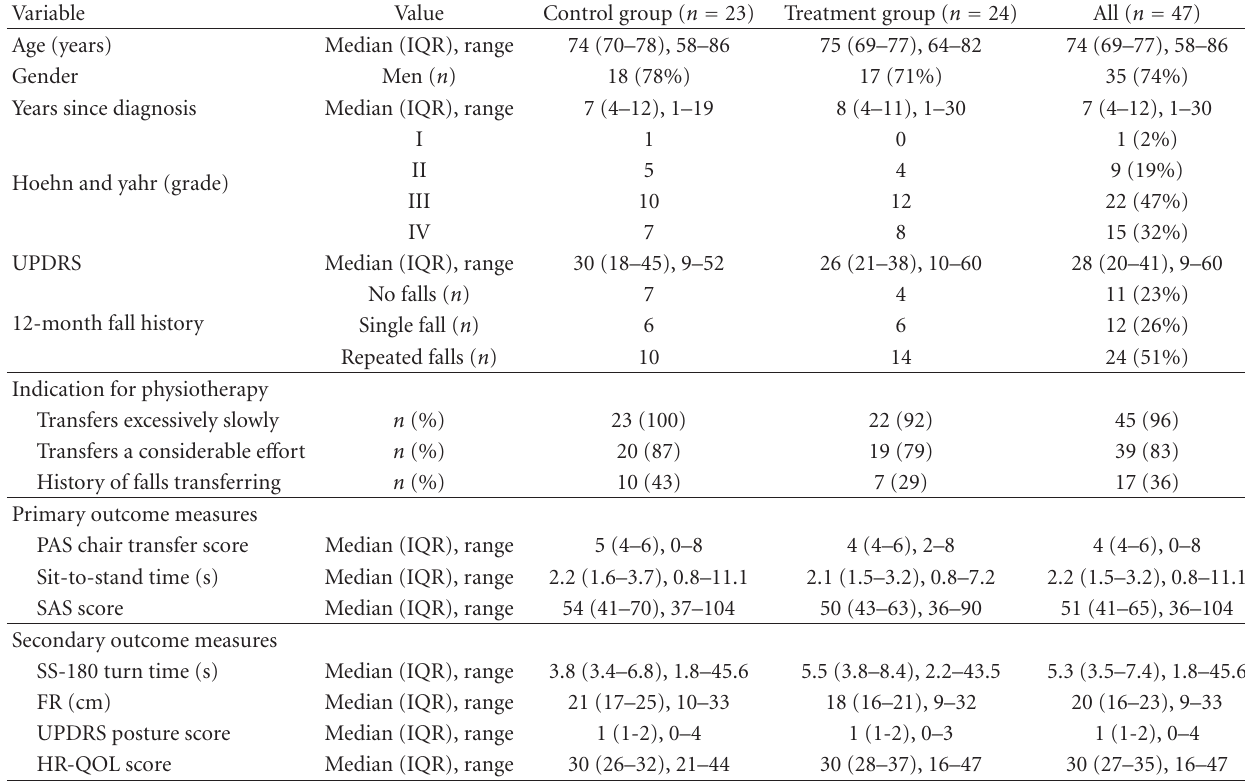
Table 1: Participant characteristics at baseline ( n = 47).